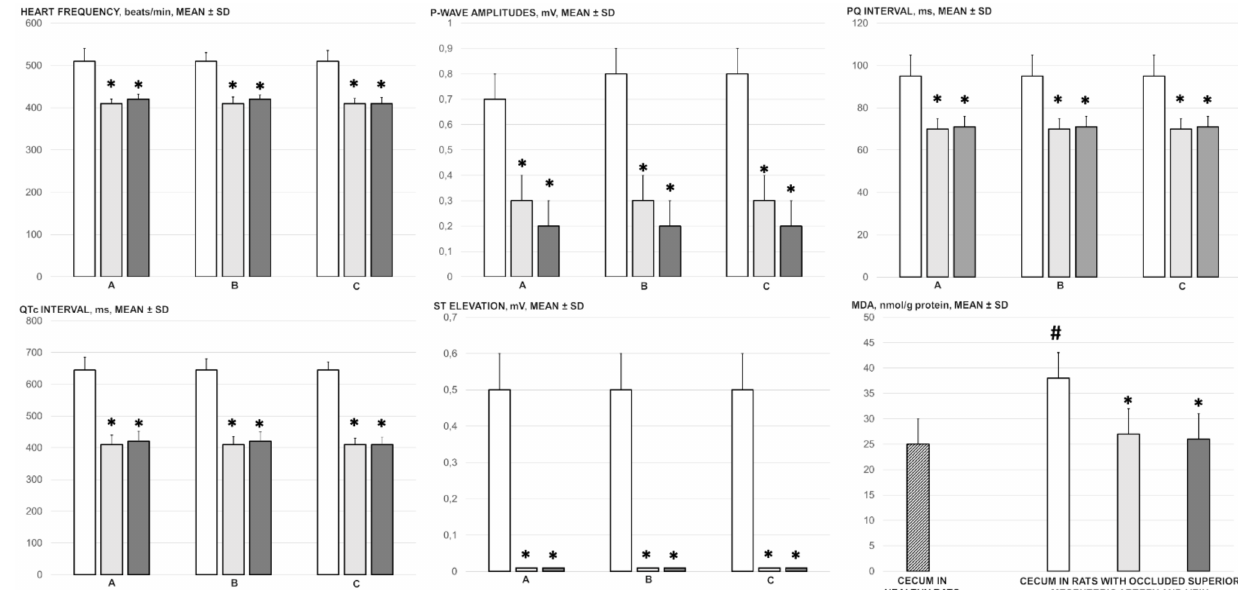
Figure 2. ECG changes (heart frequency (beats/min), P-wave amplitude (mV), PQ interval (ms), QTc interval (ms), ST- elevation (mV)) at 5 min (A), 15 min (B) and 30 min (C) ligation-time, oxidative stress (MDA, nmol/g protein), in the rats with ligated superior mesenteric vein and artery at 30 min ligation-time following medication (BPC 157 10 µ g/kg (light gray bars), 10 ng/kg (dark gray bars); saline 5 mL/kg (white bars) given intraperitoneally. Six rats/group/interval. Mean ± SD, * p < 0.05, at least vs. control, # p < 0.05, at least vs. healthy (dashed bar).